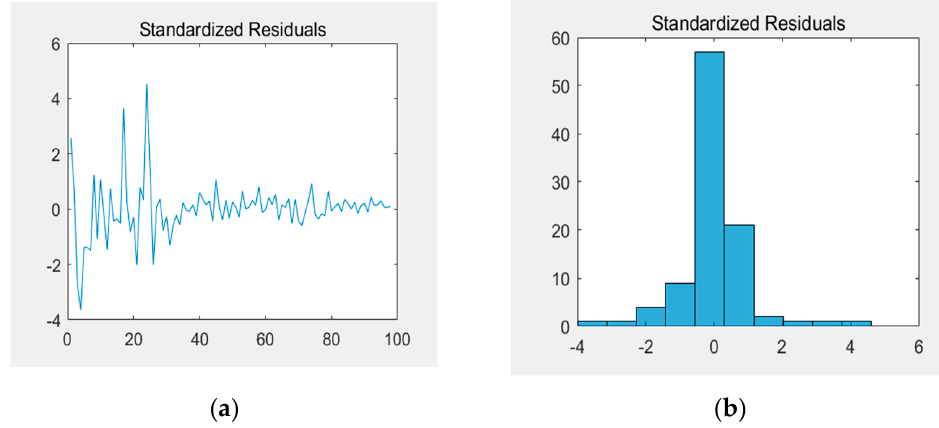
Figure 10. Standardized residuals. ( a ) Standardized residual; ( b ) Standardized residual.